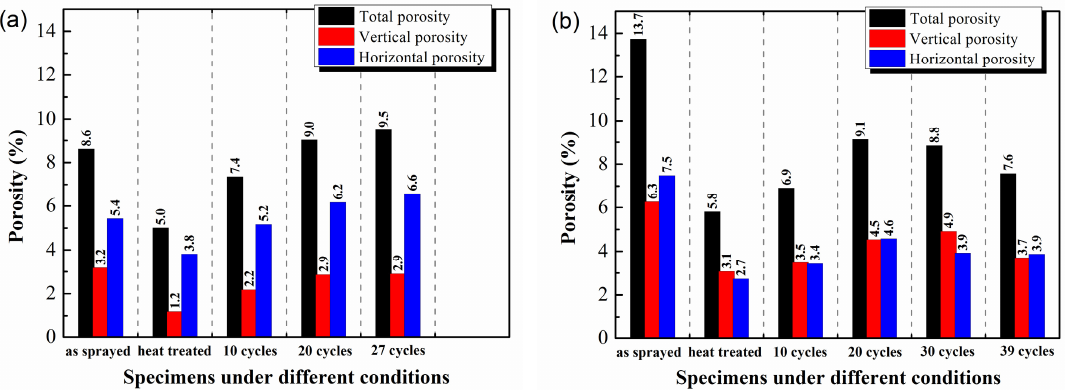
Figure 9. Evolution of pore structure of the two kinds of coatings during thermal shock test: ( a ) 15–25 μ m and ( b ) 45–60 μ m.